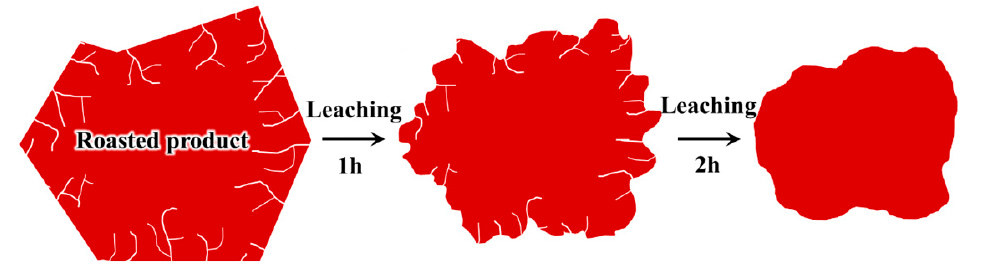
Figure 7. Graphical diagram for the dissolution process of the roasted product.